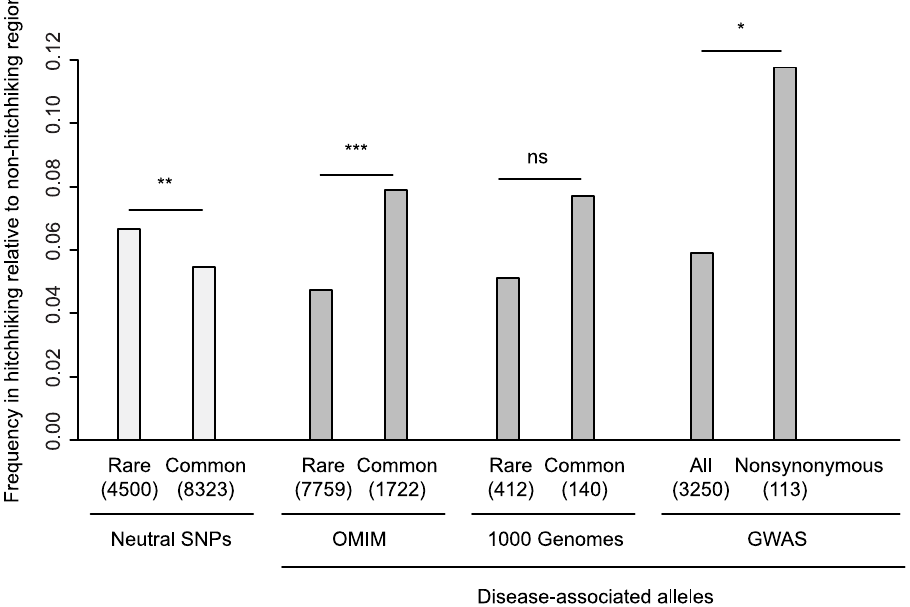
Figure 5. Enrichment of disease-associated alleles in hitchhiking relative to non-hitchhiking regions. Each category shows the number within hitchhiking to non-hitchhiking regions, where hitchhiking regions were defined by the overlap of three or more tests of selection. Neutral SNPs are from HapMap Phase II. Disease alleles in 1000 Genomes columns are based on the Human Gene Mutation Database. The sample size of each category is shown in parentheses. Bars show one-sided Fisher’s Exact test comparisons, not significant (ns), P , 0.05 (*), P , 0.01 (**), and P , 0.001 (***).